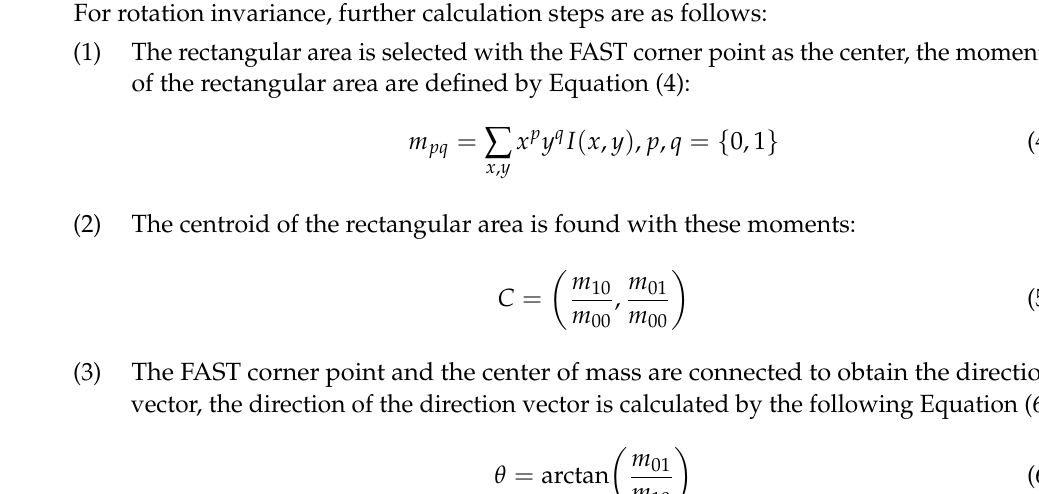
Figure 2. ROI (inside the red rectangle) area cropped in the original image.